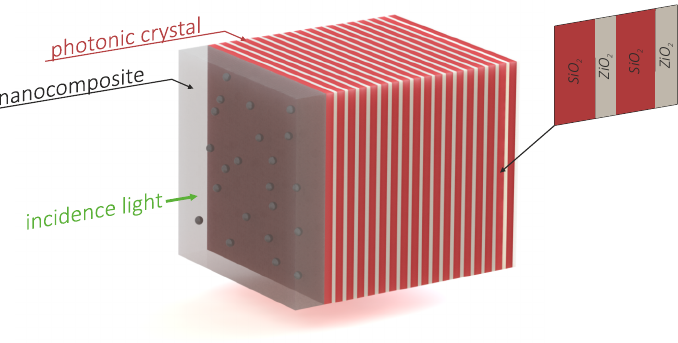
Figure 1. Schematic of a one-dimensional PhC bounded by a nanocomposite